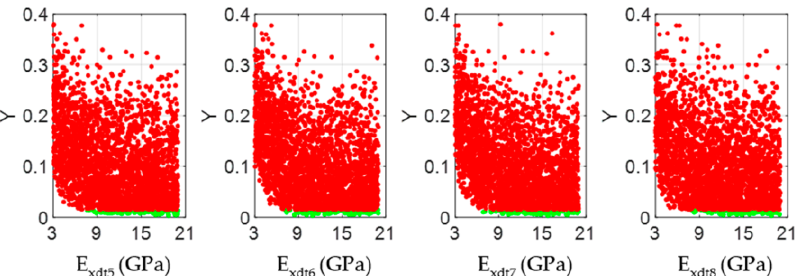
Figure 12. Scatter plots of the output samples (Y function) against the four input factors located in the central third of the timber board # 33 ( E xdt in zones 5 to 8). The green and red dots represent the sets B (behavioral) and NB (non-behavioral), respectively.